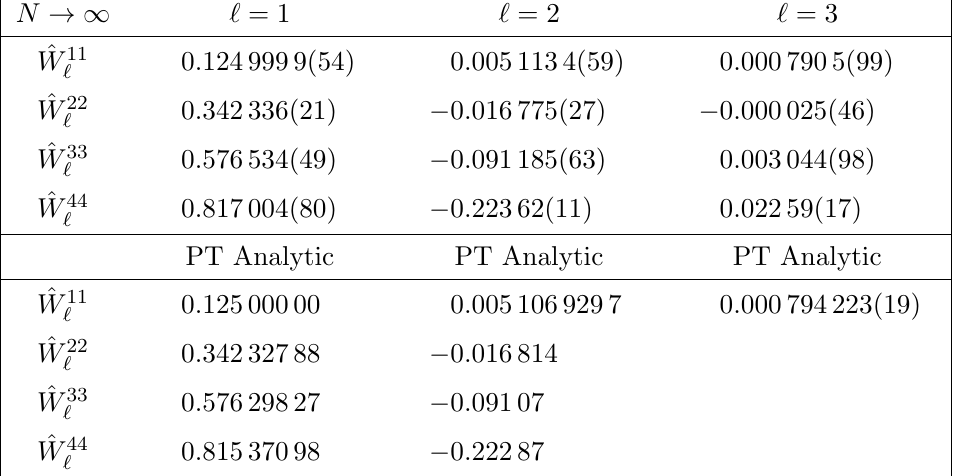
in N ! 1 . Values in PT Analytic for ^ W 11 ‘